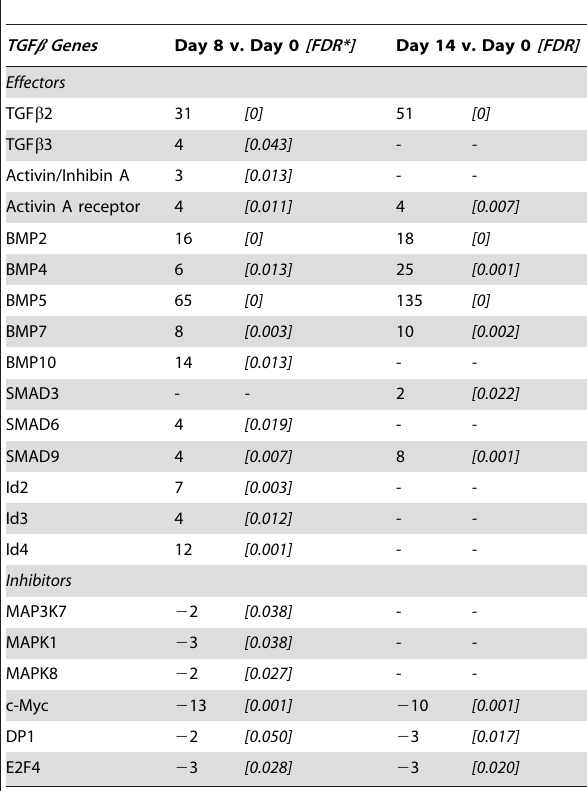
Table 3. Fold-changes in TGF b Pathway Genes.